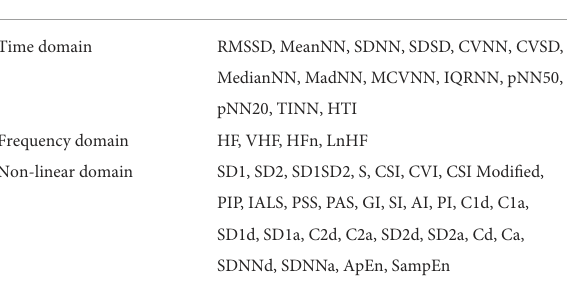
TABLE 3 ECG features used in this